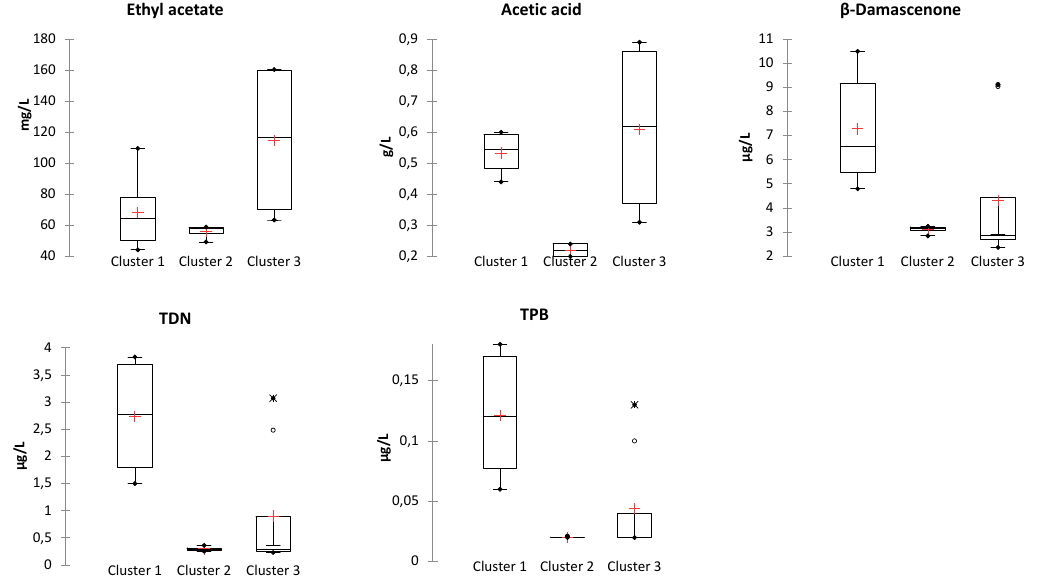
Figure 6. Box plots of significantly different compounds (Kruskal–Wallis, α = 0.05) between sensory clusters of Corvinone wines.